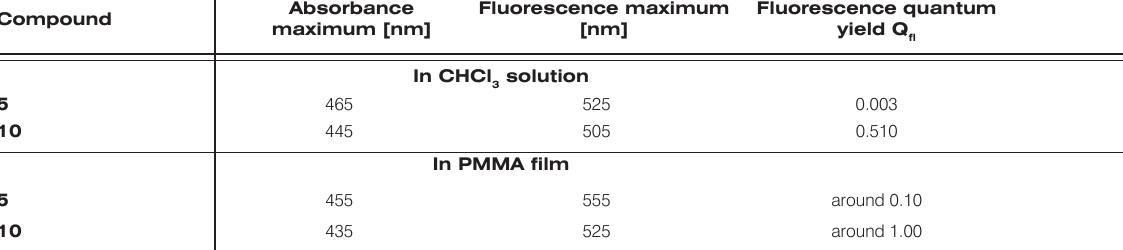
solution and PMMA film. 3